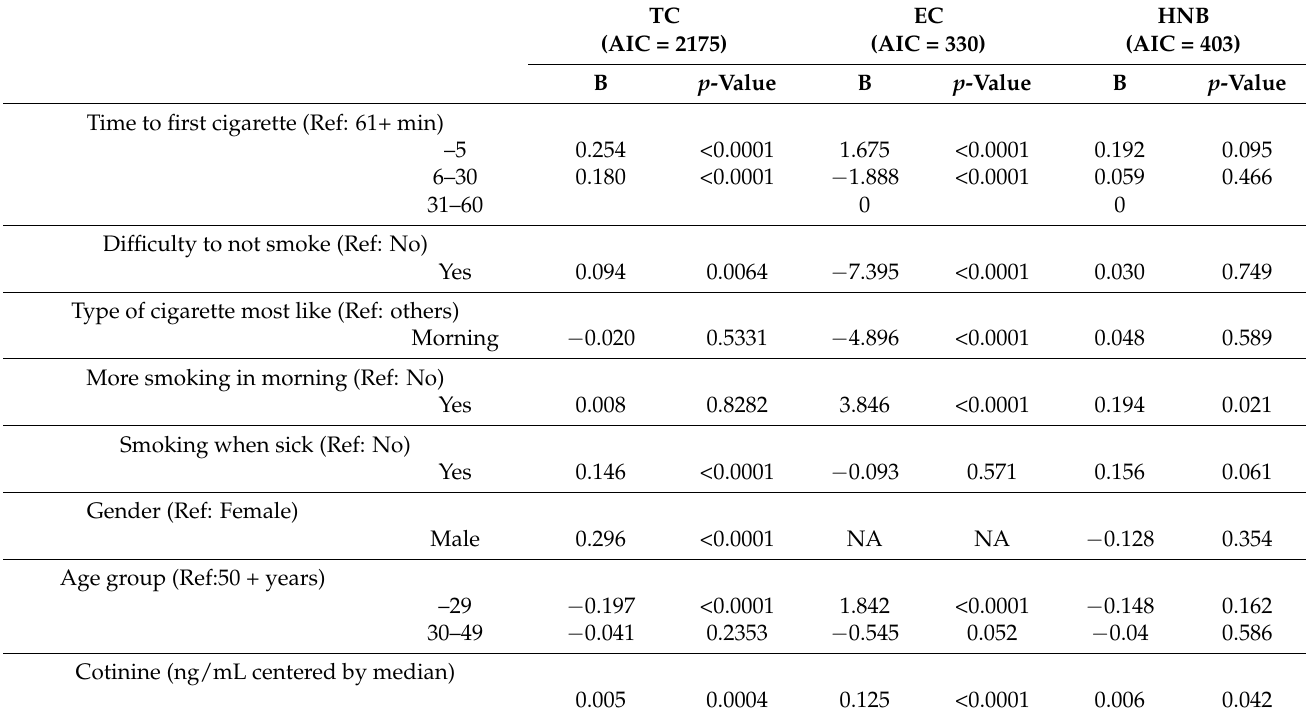
Table 5. Association between daily smoking amount and nicotine addiction levels adjusted for age sex and urinary cotinine